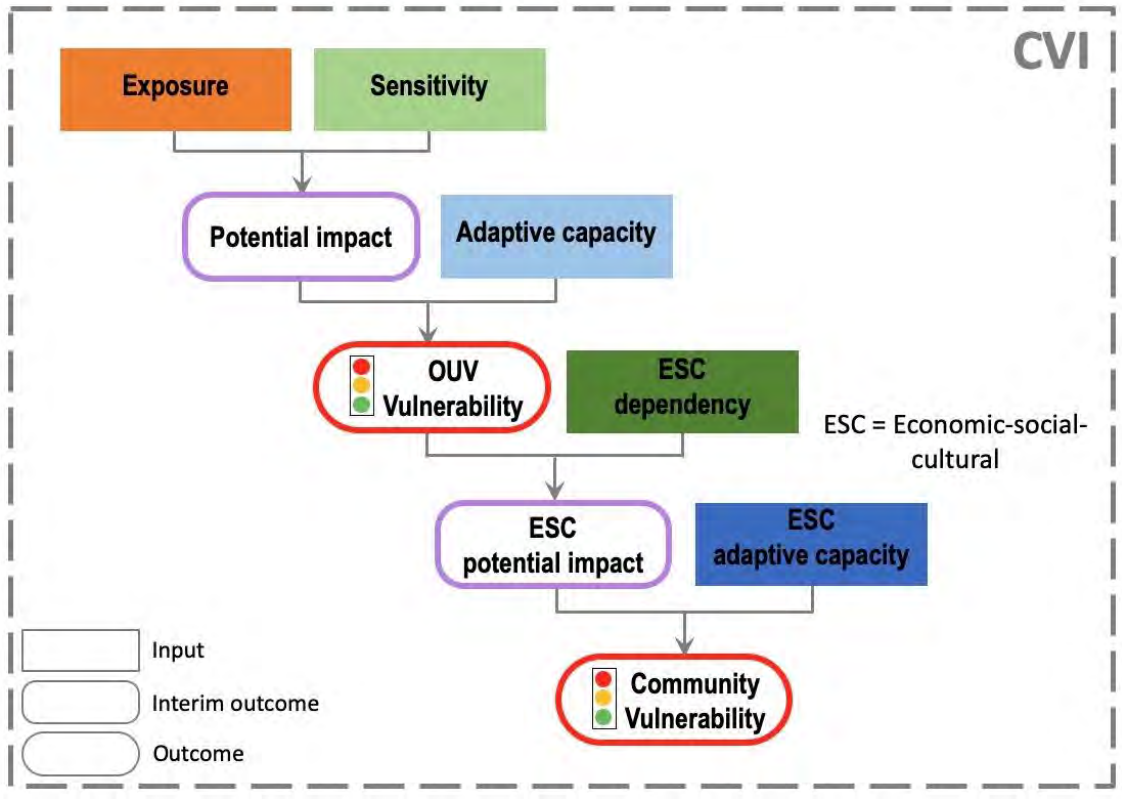
Figure 5.1 The CVI framework to undertake rapid assessment of climate change vulnerability of World Heritage properties and associated